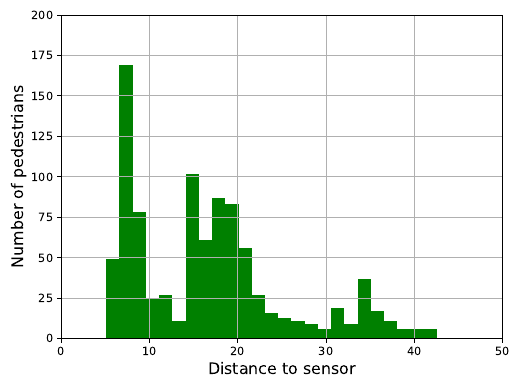
Figure 3. Measuring distances to fully visible pedestrians occurring in the evaluation data